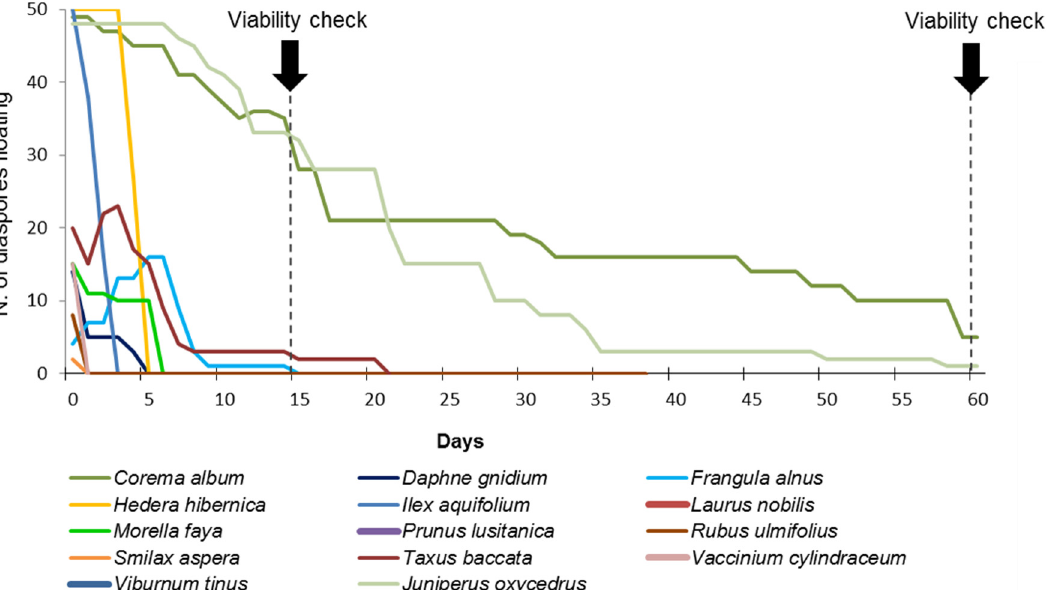
Fig 2. Number of fruits remained floating during prolonged immersion in saltwater. Floatation potential of Azorean fleshy fruits. Each line represents the fate (floating/sunk) of 50 fruits from each of the 14 fleshy-fruited species that naturally colonized the Azores.